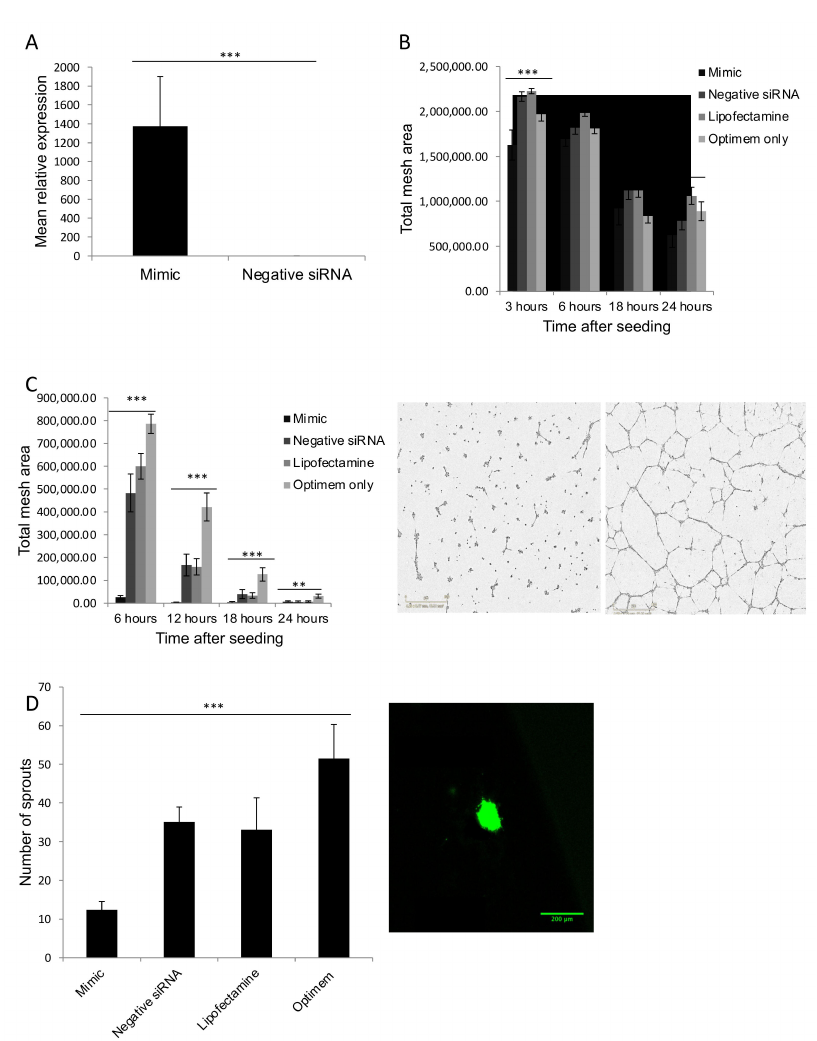
Figure 3. MiR overexpression in endothelial tissue. ( A ) Transfection of HUVEC cells with miR mimic: Since miR-181/-429 were upregulated in COPD lung, a mimic was used to test function. The mimic successfully upregulated the miR in HUVECs 3 days after transfection ( n = 3 in both groups), *** = p < 0.001. ( B ) Number of nodes formed by HUVECs imbedded in Matrigel after transfection of miR-429 mimic. The figure shows the number of nodes present 3, 6, 18 and 24 h after HUVECs were seeded on Matrigel. The numbers represent the mean from 3 separate experiments. An ANOVA test was used to look for significance between groups. * = p < 0.05 (ANOVA); *** = p <0.001. Tukey’s test was used to compare groups, which demonstrated that number of nodes was significantly reduced in the mimic group in comparison to the negative siRNA group at 3 h ( p < 0.001), suggesting that miR-429 reduces angiogenesis. ( C ) Total mesh area formed by HUVECs embedded in Matrigel after transfection of miR-181b-3p mimic: the figure shows the total mesh area present 6, 12, 18 and 24 h after HUVECs were seeded on Matrigel. The numbers represent the mean from 3 separate experiments. An ANOVA test was used to look for significance between groups. ** = p < 0.01 (ANOVA); *** = p <0.001. Tukey’s test was used to compare groups, which demonstrated that total mesh area was significantly reduced in the mimic group in comparison to the negative siRNA group at 6 ( p < 0.01 and 12 h ( p = 0.042), suggesting that miR-181b-3p reduces angiogenesis. Representative images from these experiments are shown; the picture on the left shows HUVECs at 12 h transfected with the miR mimic, and on the right with the negative siRNA. Scale bars represent 800 µ m. ( D ) Number of endothelial sprouts from spheroids after transfection of a miR-181b-3p mimic: the figure shows the total number of endothelial sprouts for each condition. The numbers represent the mean from 3 separate experiments. An ANOVA test was used to look for significance between groups. *** = p <0.001 (ANOVA). Tukey’s test was used to compare groups, which demonstrated that number of sprouts was significantly reduced in the mimic group in comparison to the negative siRNA group. Representative images from these experiments are shown; the picture on the left shows HUVECs transfected with the miR mimic, and on the right with the negative siRNA. Scale bars represent 200 µ